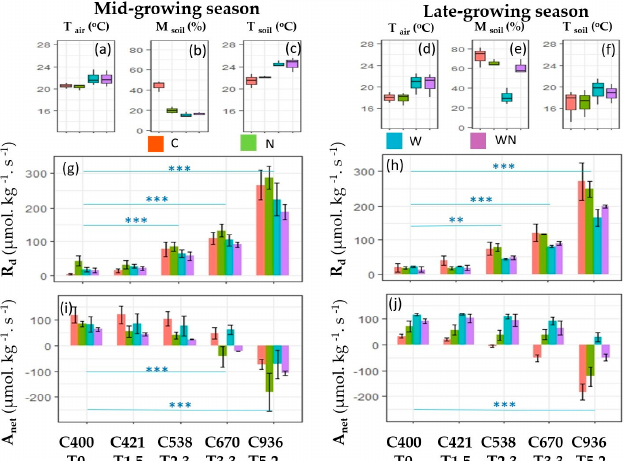
Figure 2. The dark respiration (R d ) ((g) for the mid-growing season, (h) for the late-growing season) and net photosynthesis (A net ) ((i) for the mid-growing season, (j) for the late-growing season) of G. bigeloviana in both CO 2 and temperature increments (CTI) conditions stimulating future climate sce- narios for the year 2100 in the Control (C-red bars), N addition (N-green bars), warming (W-blue bars) and both N addition and warming (NW-purple bars) plots. Error bars represent the standard error of the mean (n = 3). Stars indicate the p -value of the Tukey test for significant differences of R d and A net between levels of CTI ( p < 0.05, **: p < 0.01, ***: p < 0.001). Box plots show environmental variables, including air temperature (T air ) ((a) for the mid-growing season), (d) for the late-growing season), soil moisture (M soil ) ((b) for the mid-growing season), (e) for the late-growing season), and soil temperature (T soil ) ((c) for the mid-growing season), (f) for the late-growing season).